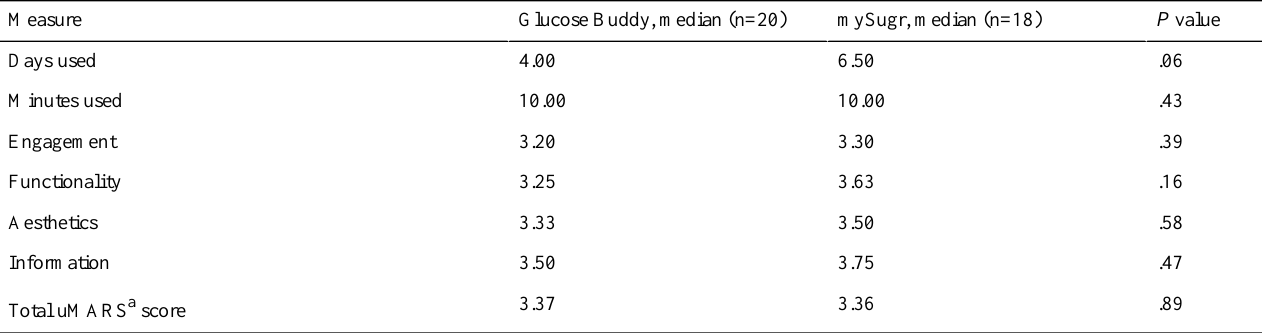
Table 2. Self-reported user engagement of the 2 apps.